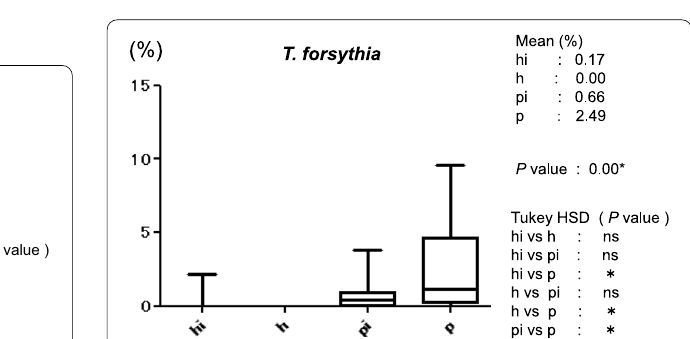
Fig. 6 Average proportion (%) of bacteria to total copy-count for Tannerella forsythia